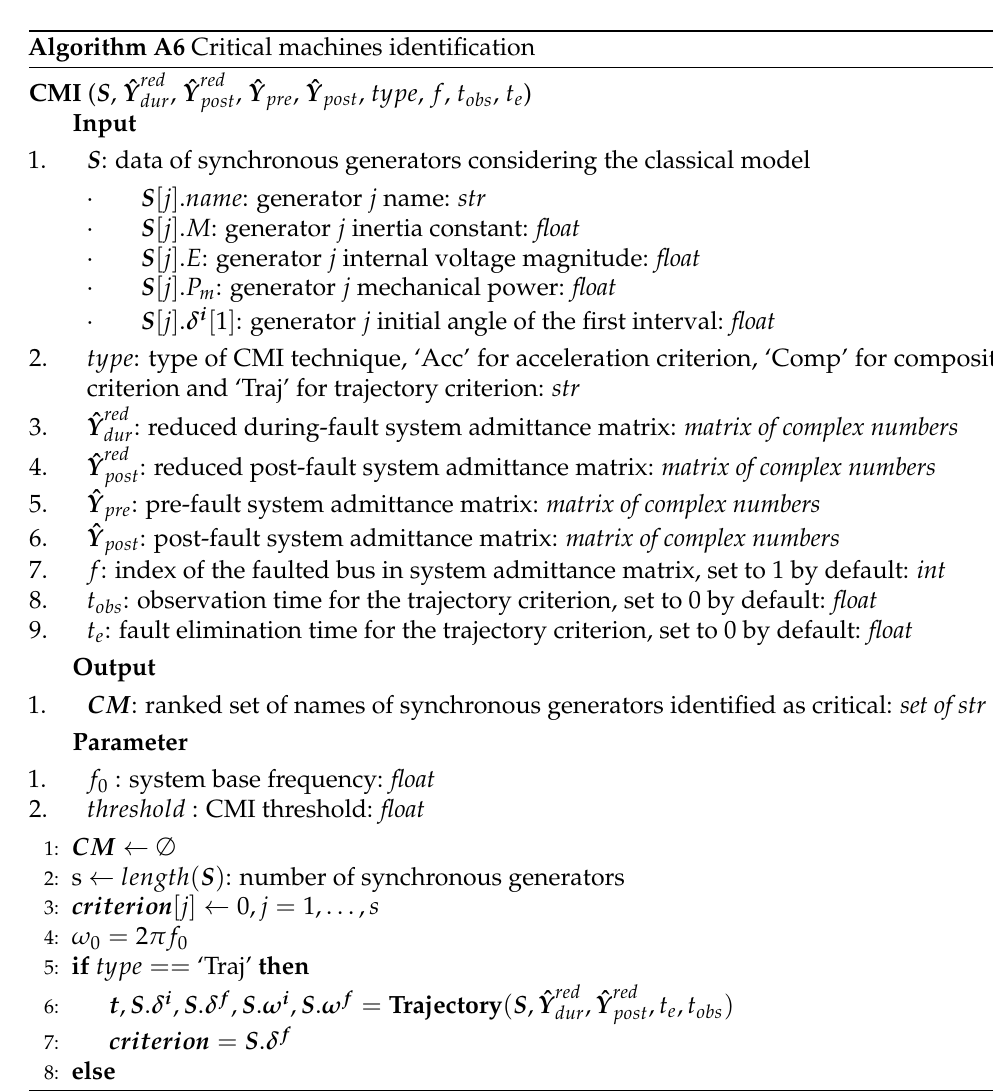
Algorithm A6 Critical machines